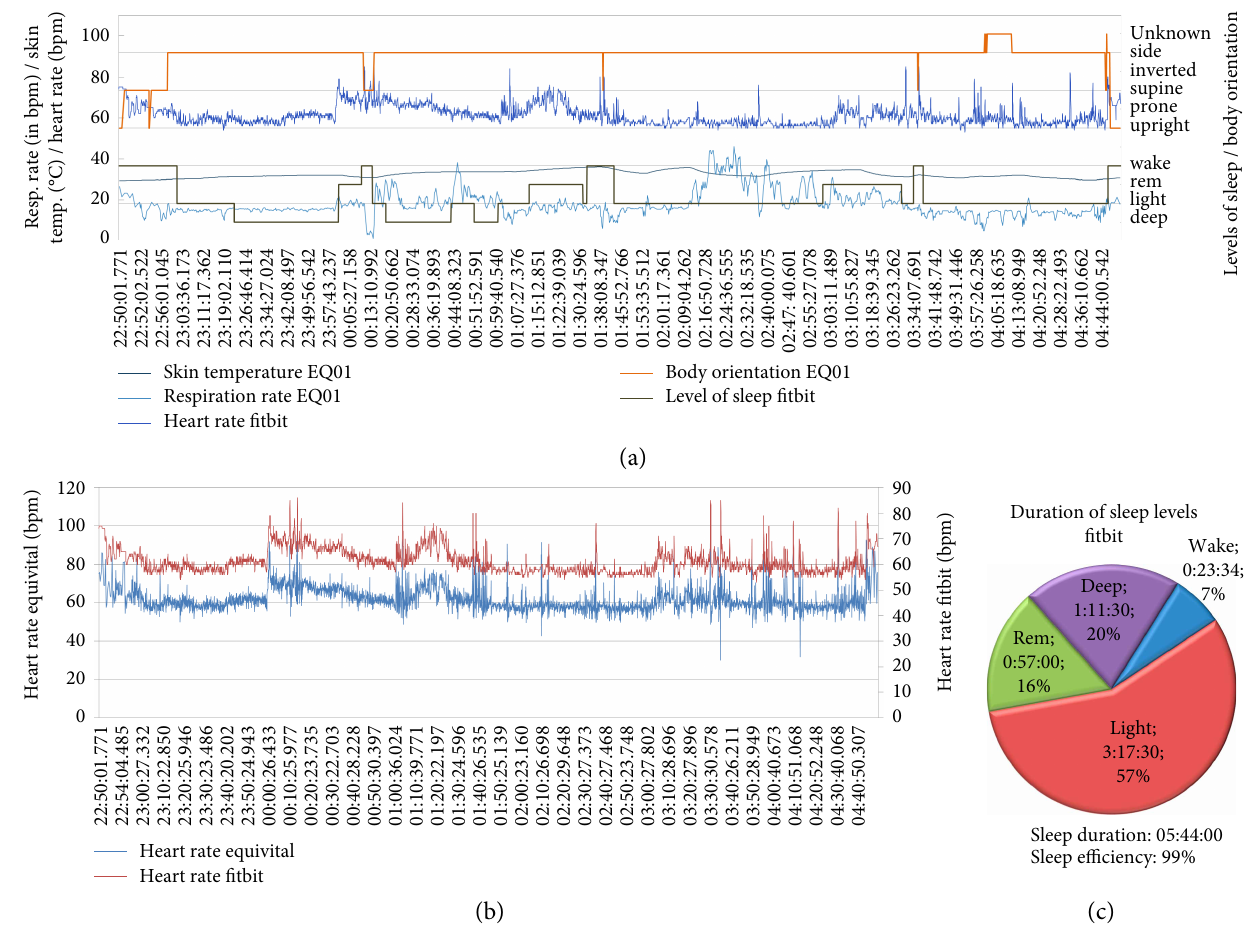
Figure 10: Individual data sets of one subject (2) for overnight monitoring: (a) prepared time-based data for the transfer to the p 2 Health-Cloud ; (b) comparison of the heart rate from both sensor devices; (c) prepared statistical data for the transfer to the p 2